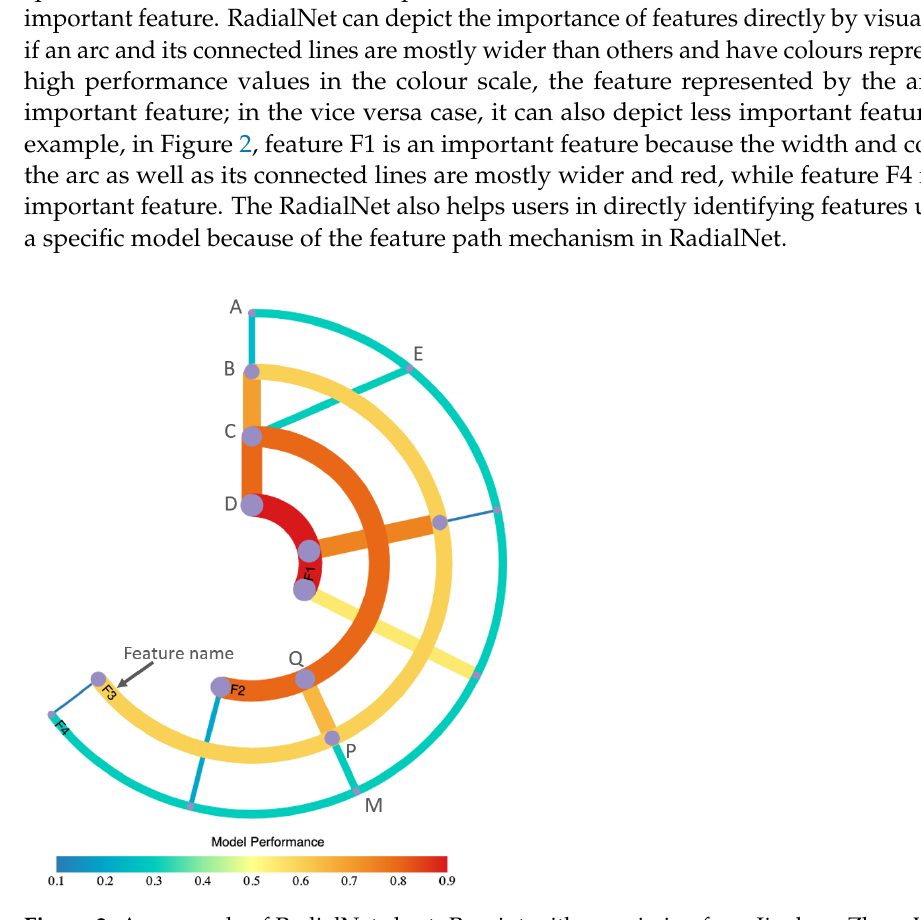
Figure 2. An example of RadialNet chart. Reprint with permission from Jianlong Zhou, Weidong Huang and Fang Chen (2020). Copyright 2020 IEEE Pacific Visualization Symposium (PacificVis).